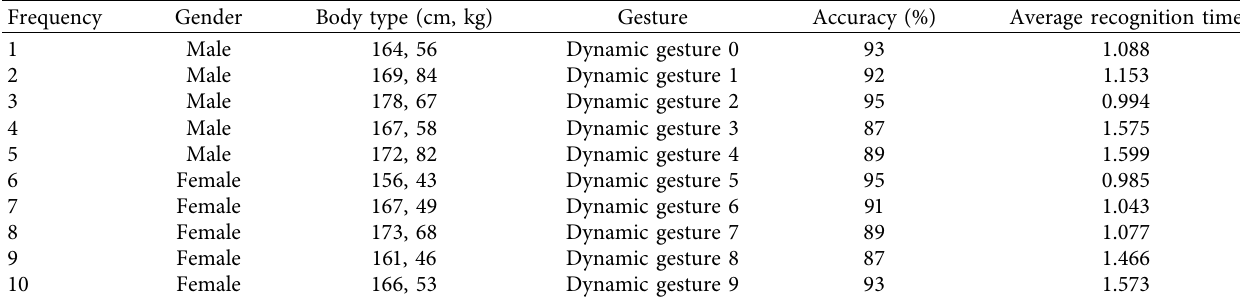
Table 5: Human-computer interaction system test result.